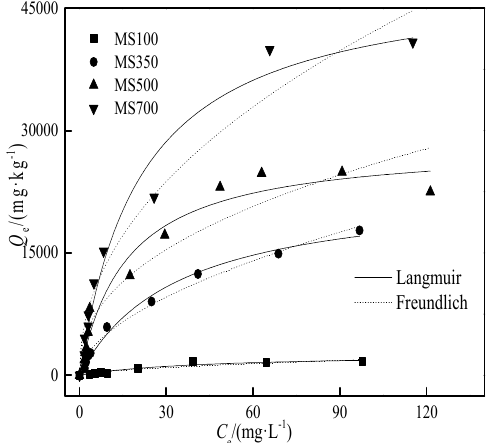
Figure 6. The Cd adsorption isotherms of the biochars.